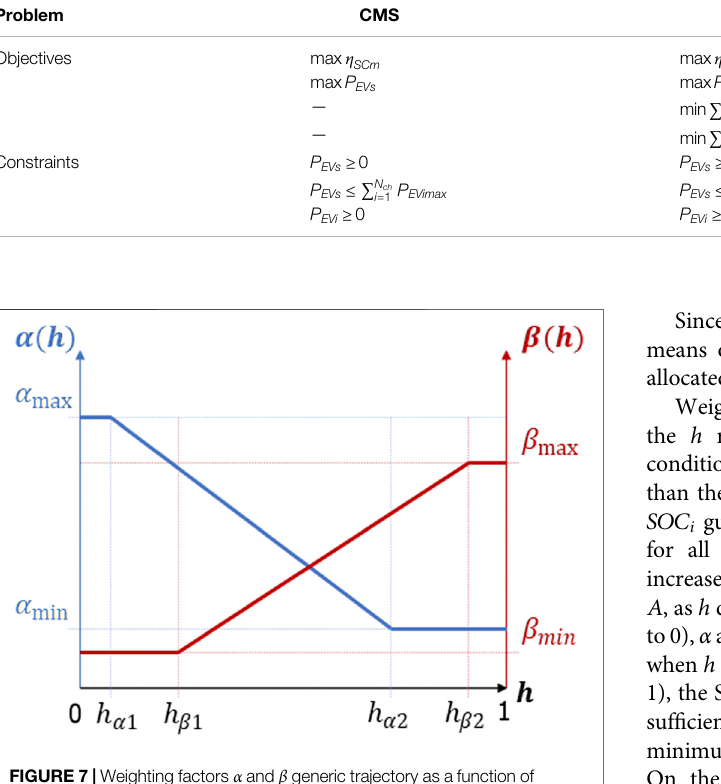
FIGURE 7 | Weighting factors α and β generic trajectory as a function of the h